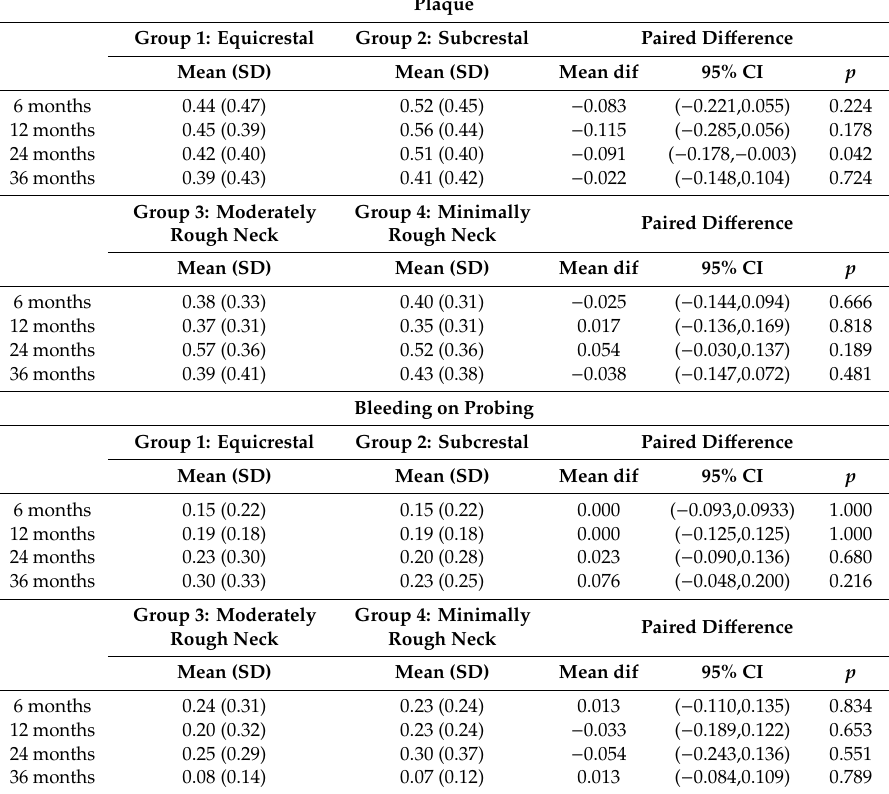
Table 3. Mean plaque and bleeding on probing on implant level at 6, 12, 24 and 36 month for each study group and mean di ff erence between respectively equicrestally versus subcrestally placed implants and implants with moderately rough versus minimally rough neck; p < 0.05 indicates a statistically significant di ff erence (paired t